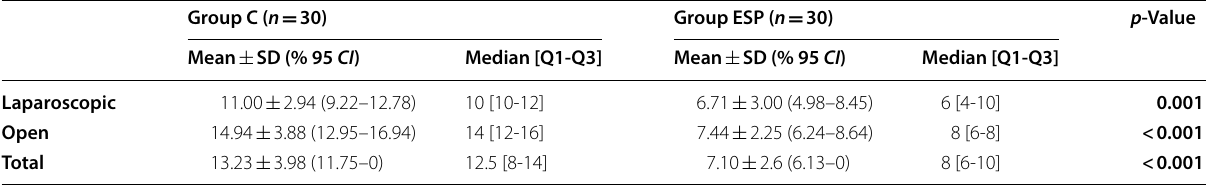
Note: Data are expressed as mean standard deviation (% 95 CI) and median ([IQR, Q1–Q3]). Statistically significant difference is highlighted in ±